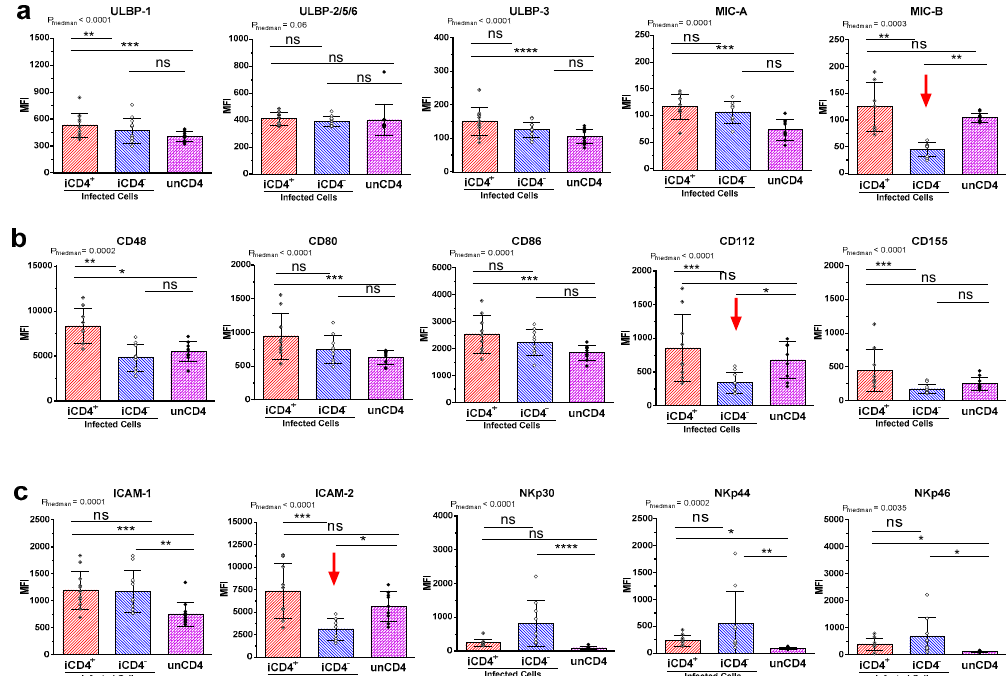
Figure 3. Mean fluorescence intensity (MFI) of aNKR ligand expressing T cell subsets. Comparison of the per-cell expression of Panel 1, 2, and 3 ligands to aNKR on HIV-infected p24 + CD4 + T cells (iCD4 + ), p24 + CD4 − T cells (iCD4 − ) and HIV-uninfected p24 − CD4 + T cells (unCD4). Panel 1 ( a ) includes ULBP-1 ( n = 11), ULBP-2/5/6 ( n = 11), ULBP-3 ( n = 11), MIC-A ( n = 9), and MIC-B ( n = 9); Panel 2 ( b ) includes CD48, CD80, CD86, CD112, and CD155 ( n = 9, for all); Panel 3 ( c ) includes ICAM-1, ICAM-2, and the ligands to NKp30, NKp44, and NKp46 ( n = 9, for all). The MFI of the expression of the indicated ligand is represented on the y-axis. Friedman (P Friedman ) and Dunn’s post (*) tests were used to determine significance of within subject differences between data sets. Each data point represents T cells isolated from a separate individual. Bar height and error bars represent the mean and standard deviation for the data set. Significance values are shown over the bars linking 2 groups as * p < 0.05; ** p < 0.01; *** p < 0.001; **** p < 0.0001. Red arrows highlight ligands for aNKR expressed at a lower MFI on iCD4 − than unCD4 cells.